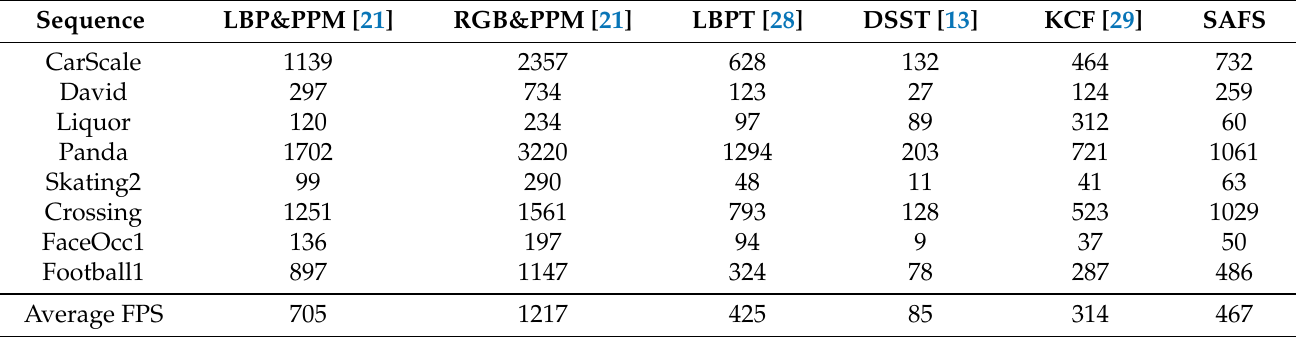
Table 4. Speed comparison of six